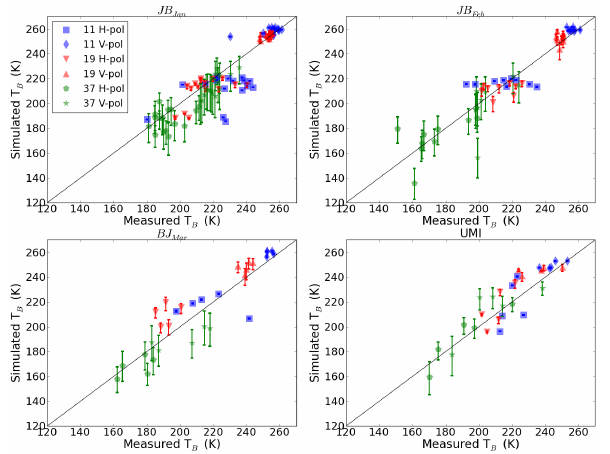
Figure 9. T B sensitivity associated to the error of SSA measure- ments (12%) for the James Bay (three dates) and Umiujaq sites. Table 9. T B sensitivity ( (cid:49)T B,SSA : T B,SSA + 12% − T B,SSA − 12% ) (K) associated with the error of SSA measurements